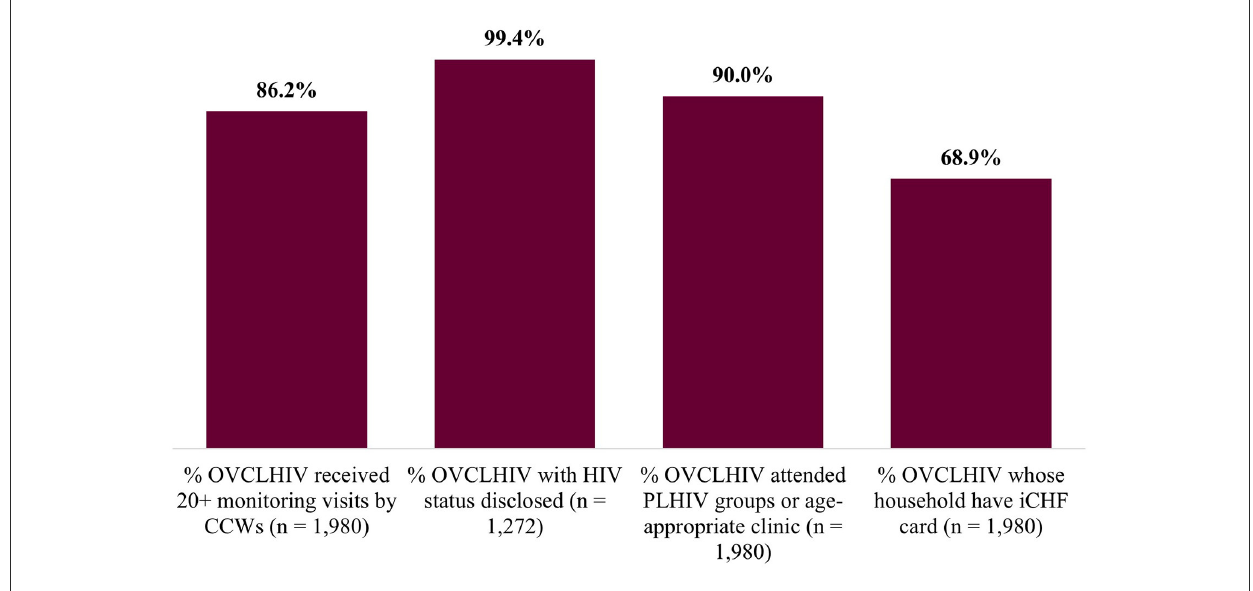
FIGURE1 Coverage of